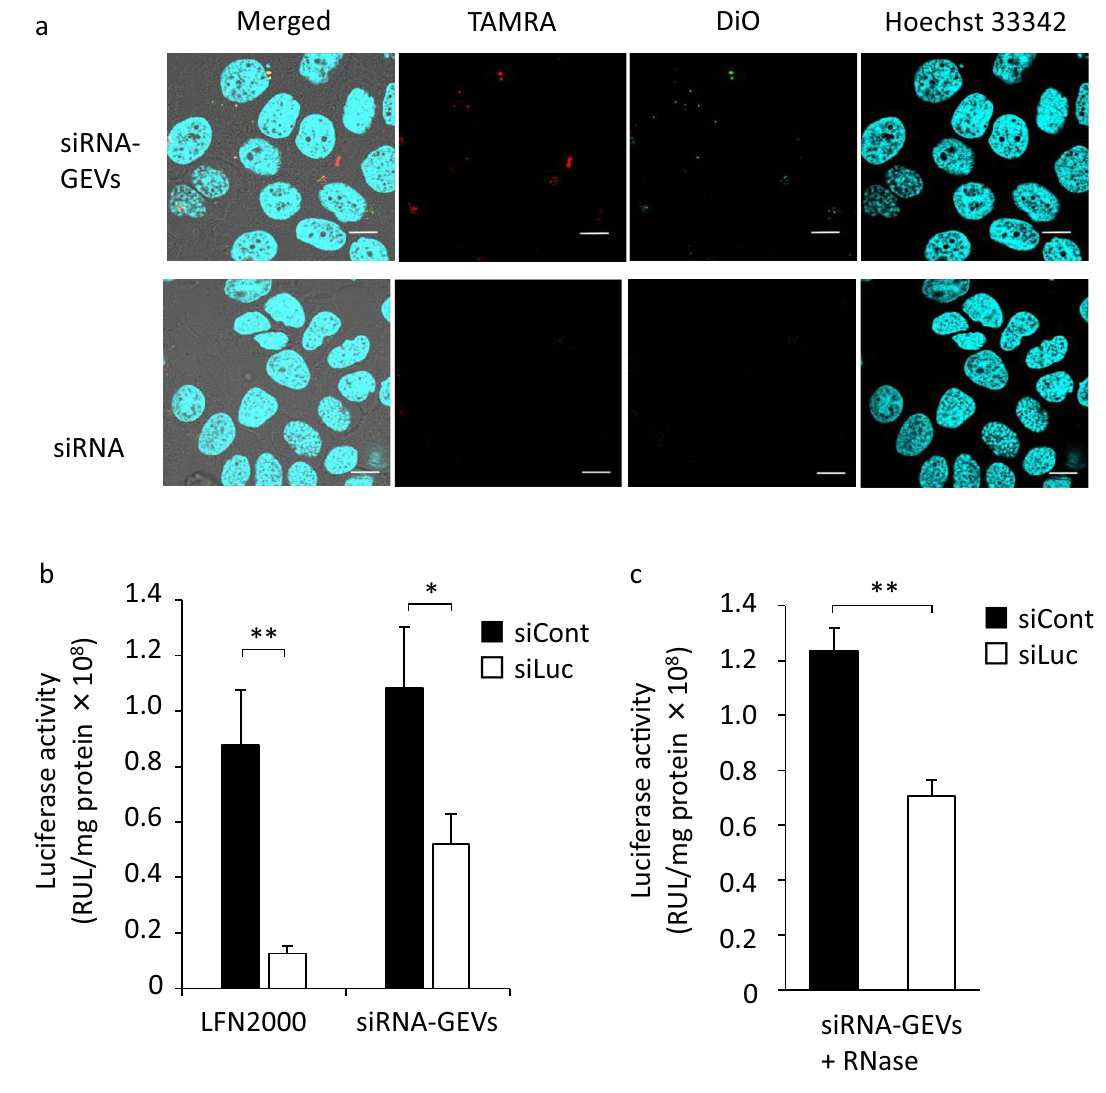
Figure 6. siRNA delivery and gene knockdown effect of siRNA-GEVs. ( a ) Intracellular delivery of siRNAs by siRNA-GEVs. HaCaT cells were treated with 3,3 ′ -dioctadecyloxacarbocyanine perchlorate (DiO)-labeled GEVs (green) encapsulating TAMRA-siRNAs (red) for 6 h. Nuclei were stained with Hoechst 33,342 (blue). Scale bars represent 100 µm. ( b ) Gene knockdown effect. siRNA-GEVs were prepared using negative control siRNAs (siCont) or anti-luciferase siRNAs (siLuc). HaCaT cells were treated with 0.2 µg plasmid DNA (pDNA) encoding luciferase for 12 h, and then 10 pmol of siRNAs was added to the cells (by treating the cells with siRNA-GEVs or lipofectamine 2000). After a 24 h incubation, luciferase activity was measured. The results are presented as the mean ± S.D. *p < 0.05, **p < 0.01 (n = 3). ( c ) Gene knockdown effect of siRNA-GEVs treated with RNase. The results are presented as the mean ± S.D. **p < 0.01 (n =